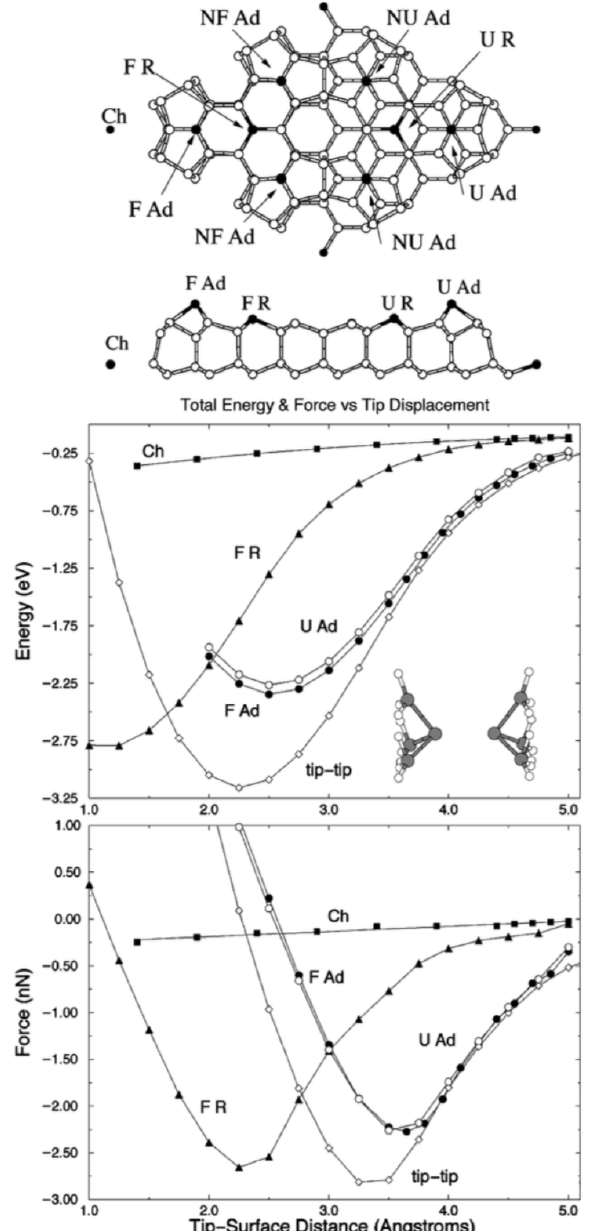
Figure 6. Short-range interaction energy middle panel and normal force bottom panel, as a function of the tip-surface distance, for tip c of Figure 1 over corner hole atom squares, over a rest atom triangles and the adatom on the long diagonal black circles in the faulted half of the unit cell, and over the adatom on the long diagonal in the unfaulted half white circles. For comparison, the interaction between two tips tip b of Figure 1 as shown in the inset, white diamonds is also shown. The top panel shows a ball-and- stick model of the 5 × 5 reconstruction, including a top view of the unit cell and a lateral view of the atoms close to the lattice plane along the long diagonal. The atoms with dangling bonds are marked: corner hole Ch, faulted F R and unfaulted U R rest atoms, faulted diagonal F Ad and off-diagonal NF Adadatoms, and unfaulted diagonal U Ad and off-diagonal NU Ad adatoms. Adapted with permission from American Physical Society from Figure 3 in